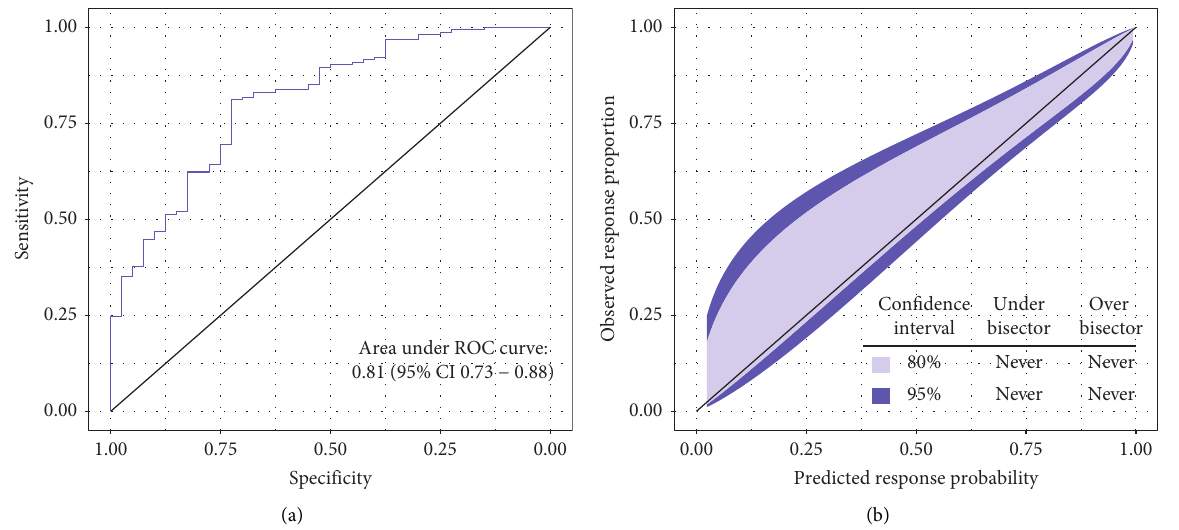
Figure 3: Predictive performance of the URS in Slovak and Croatian PBC patients. (a) AUROC 0.81 (95% CI 0.73 − 0.88) demonstrates high discrimination ability of the URS model. (b) Calibration belt confirms a well-calibrated URS model.